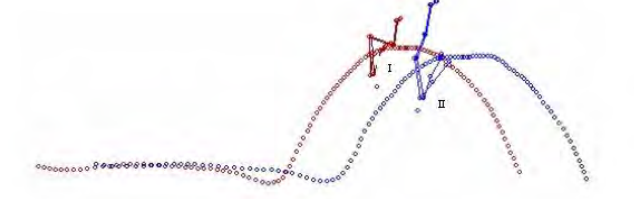
Fig.2. Starting posture of body. Resultants of speed of ankle, hip, elbow, shoulder and wrist joints as well as GMC of sportsmen’s bodies during short term fixing of starting posture for grouped back double somersault after rondat (tested A, upper section of figure, variant 1) and arched back double somersault after rondat-back turnover (tested B, lower section of figure, variant 2). : ankle –ankle joint; knee – knee joint; hip – hip joint; should – shoulder joint; elbow – elbow joint; wrist – wrist joint; c.g. – general mass center of body (GMC).